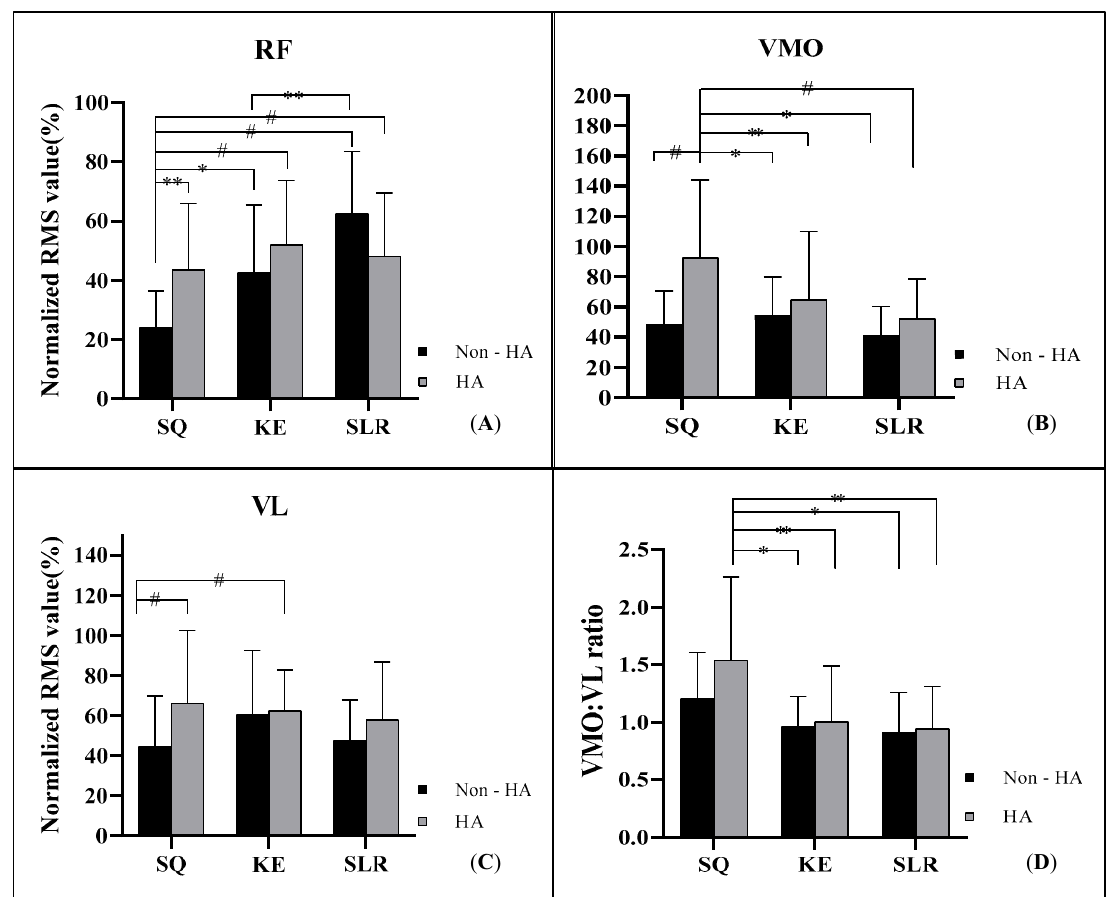
Figure 3. The EMG activity of the RF ( A ), VMO ( B ), VL ( C ) and the VMO/VL ratio ( D ) during the squat (SQ), knee extension (KE), and straight leg raise (SLR) with hip adduction (HA) or without (non-HA). The normalized RMS values are presented as mean ± SD. Significant differences among exercises are indicated by *, p < 0.05; **, p < 0.001 and # , p <0.001.